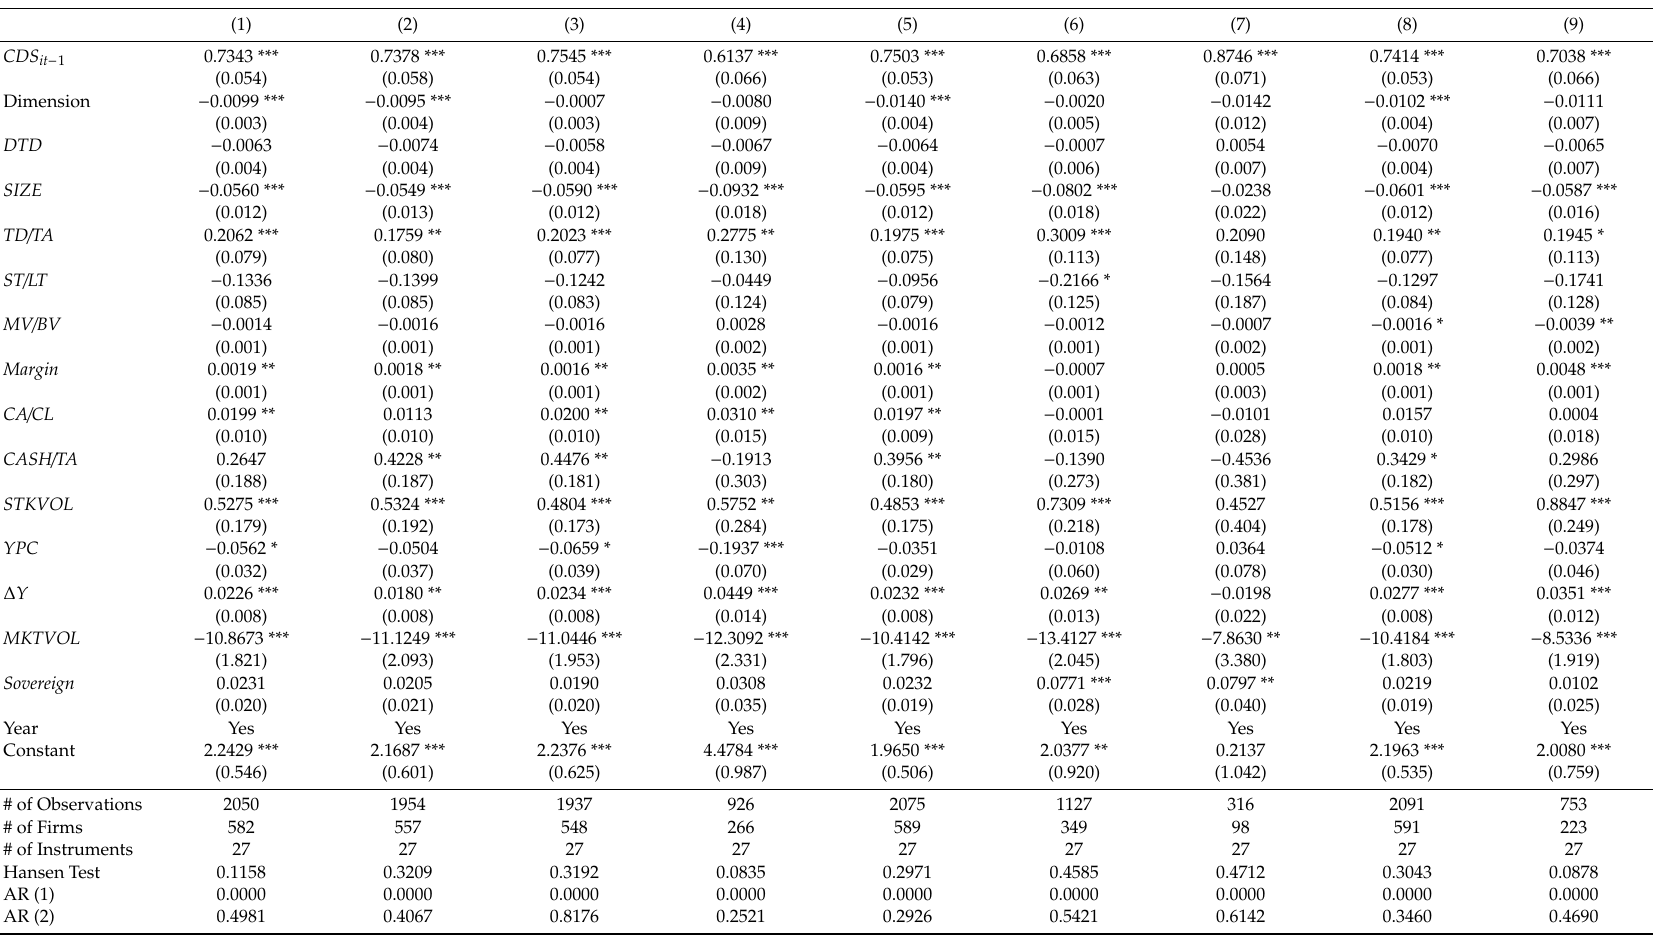
Table 4. System GMM estimation results for the e ff ects of corporate social performance (CSP) dimensions on corporate default swap (CDS)